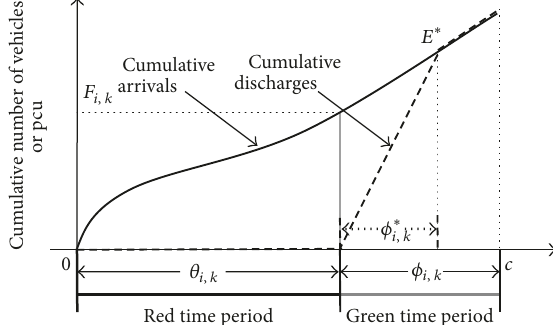
Figure 3: General vehicle queue development on approach lane 𝑘 from leg 𝑖